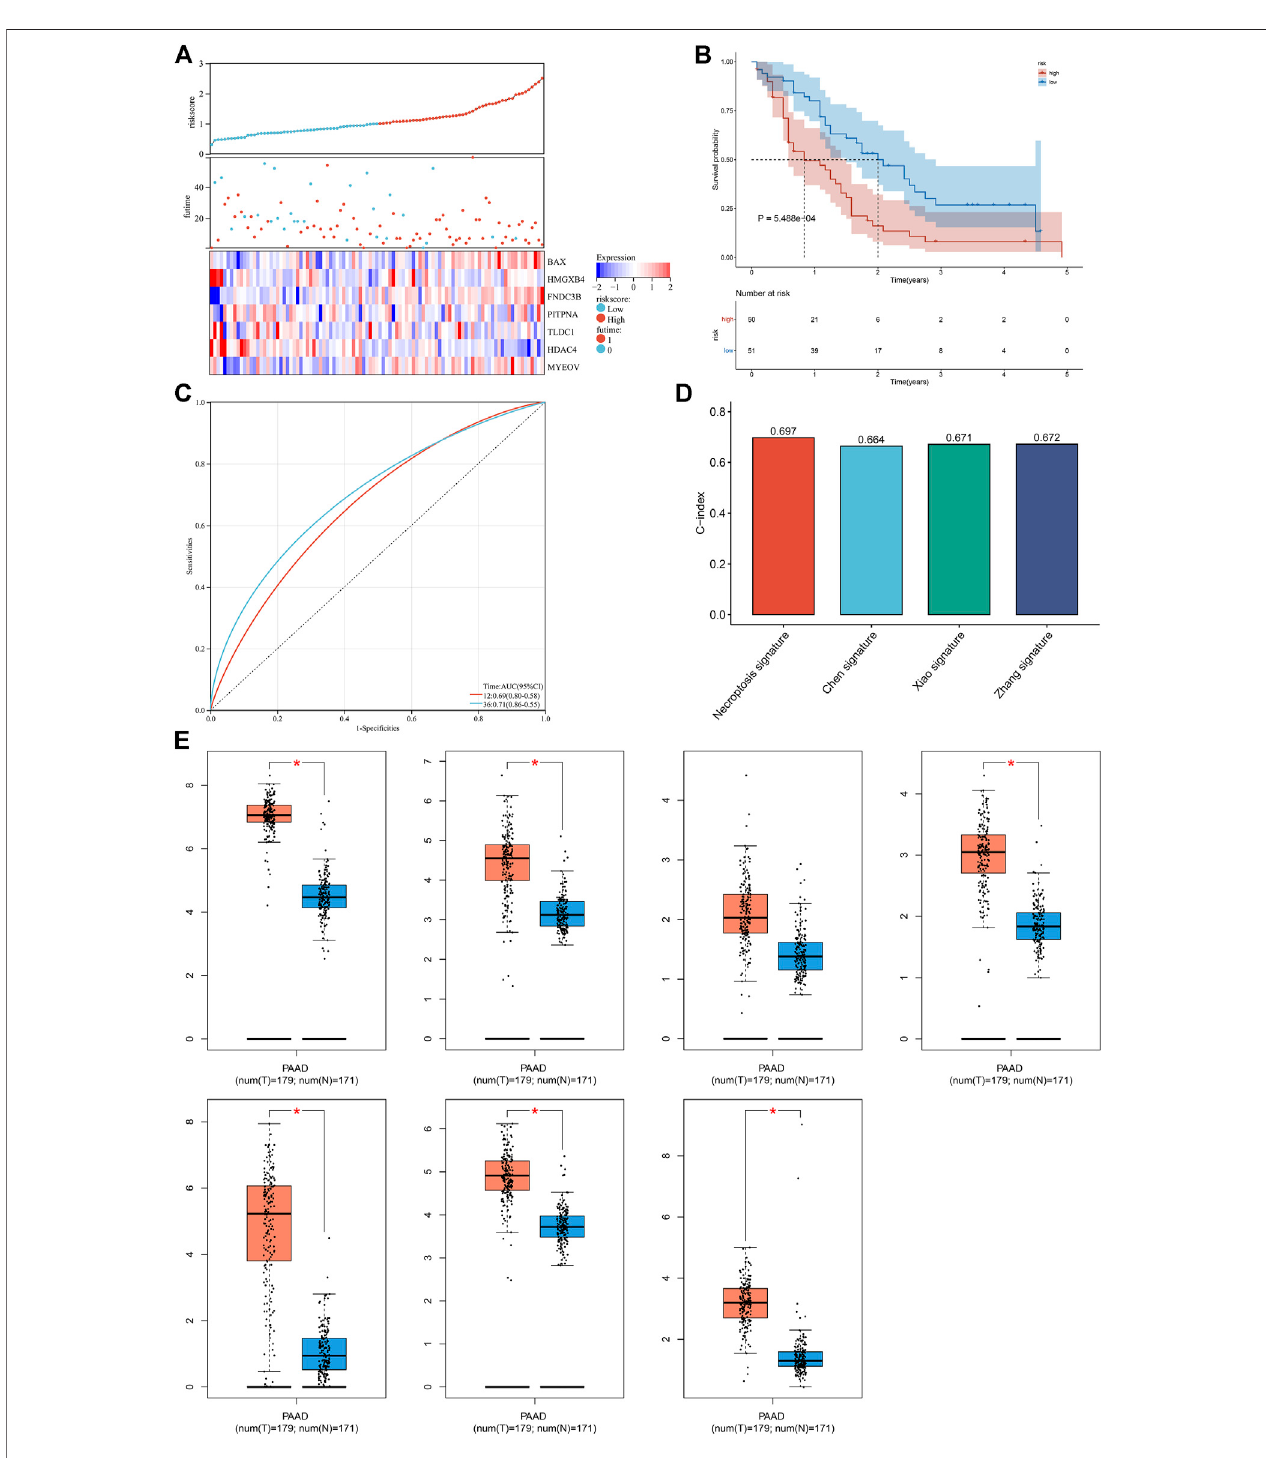
FIGURE 6 | External veri fi cation of the necroptosis-relevant risk model. (A) Distribution of the necroptosis-relevant risk score, survival status, and expression of necroptosis-relevant genes in the GSE21501 cohort. (B,C) Survival analysis and ROC curves in the GSE21501 cohort. (D) Comparison of the C-index of the necroptosis-relevant risk score with known prognostic signatures. (E) Box plots of the expression of necroptosis-relevant genes using the GEPIA web tool. * p < 0.05.